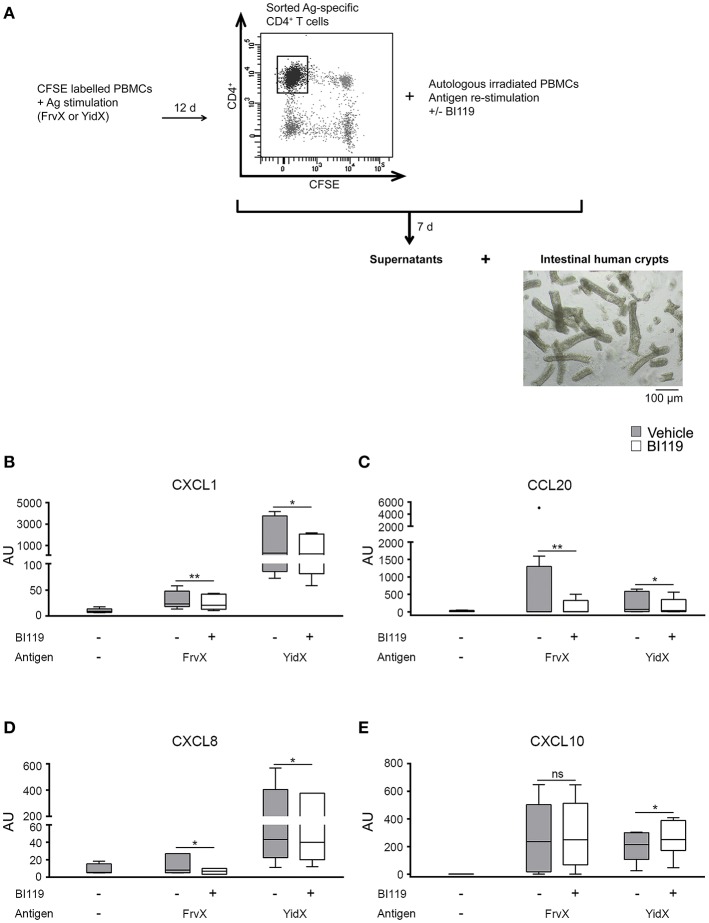
RORγt inhibition of activated antigen-specific CD4+ T cells reduces the expression of neutrophil-recruiting chemokines by intestinal epithelial crypts. (A) Schematic figure of experimental plan. CFSE-labeled PBMCs were stimulated with FrvX (n = 8) or YidX (n = 7) during 12 days. Responding CFSE−CD4+ T cells were sorted and re-stimulated with their cognate antigen and were treated or not with BI119. After 7 days supernatants were obtained from these cultures, and added to intestinal human crypts (n = 5). After overnight culture RNA of the crypts was extracted. Messenger RNA expression of (B) CXCL1, (C) CCL20, (D) CXCL8, and (E) CXCL10 was assessed by real-time polymerase chain reaction. Mean ± SEM. ns > 0.05, *P ≤ 0.05, **P<0.005.